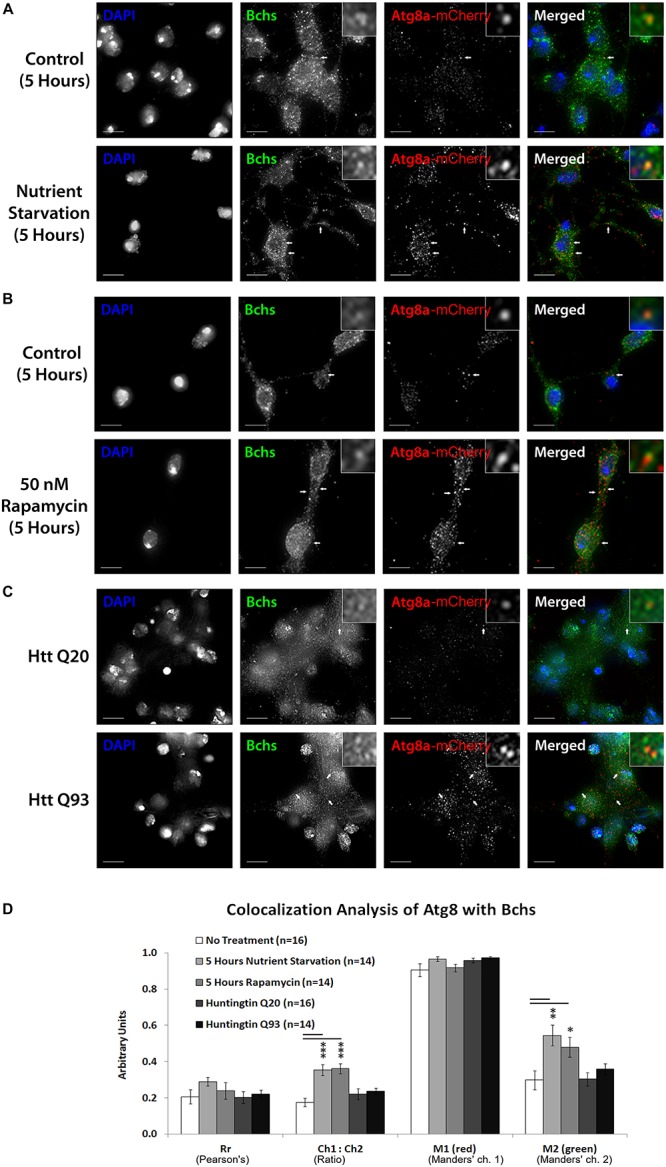
Nutrient starvation and rapamycin treatment gave a significant increase in the relative quantity of mCherry-Atg8a to Bchs (expressed by the Ch1:Ch2 value), likely explained by an increase in vesicular localization of the transgenically expressed tagged mCherry-Atg8a protein upon autophagy induction (A,B,D). The amount of Bchs colocalizing with this mCherry-Atg8a (M2) also increased significantly (D). In contrast, Htt Q93 expression did not increase M2 (C,D), as it had with RFP-Atg5 (compare Figure 5D). These results show that Bchs increases its localization with mCherry-Atg8a-tagged compartments upon general (starvation-induced) autophagy, but not after aggregate induction.